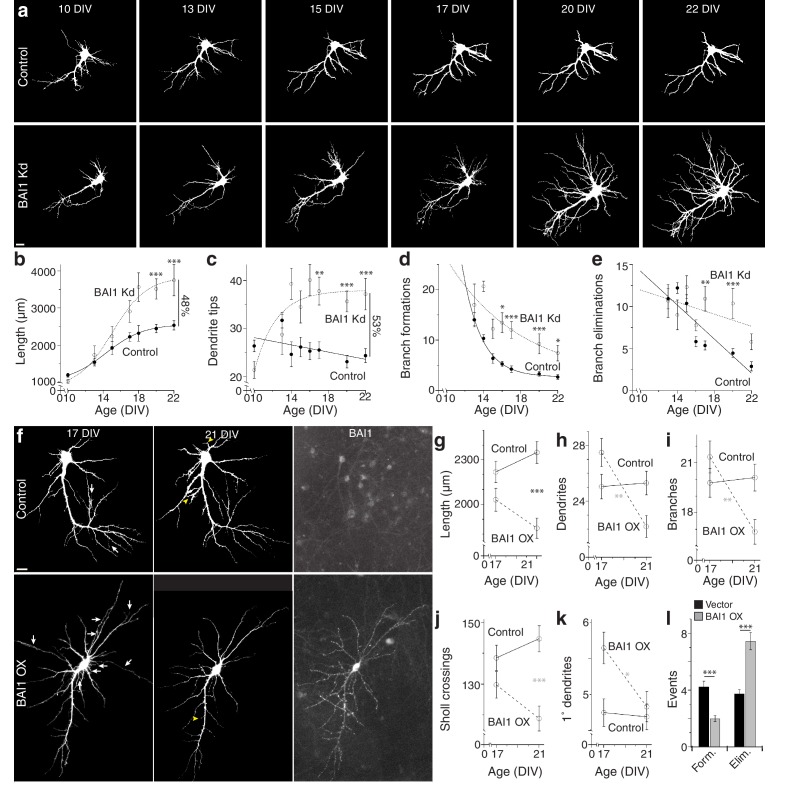
BAI1 exercises its effects on dendritic growth arrest late in development.(a) Representative longitudinal series from neurons transfected on 6 DIV with EGFP (Control) or EGFP and shRNA against Adgrb1 (BAI1 Kd) imaged at the indicated times. Images are masked to remove axons and dendrites from other neurons. Bar is 10 µm. (b) Summary data of total dendrite length. (c) Summary data of total dendrite number. (d) Summary data of branch formations. (e) Summary data of branch eliminations. Total number of neurons represented in panels a–e): 61 for control neurons and 22 for BAI1 Kd neurons (N = 5). Data are represented as mean ± s.e.m. with mathematical fits. (f) Representative longitudinal images of neurons expressing EGFP alone (Control) or with overexpression of Adgrb1 (BAI1 OX). Neurons were fixed on 21 DIV and immunostained for BAI1. White arrows in the 17 DIV panels indicate dendrites eliminated by 21 DIV, while yellow arrowheads in 21 DIV panels indicate dendrites formed since 17 DIV. Images are masked to remove axons and dendrites from other neurons. Bar is 10 µm. (g) Summary data for dendrite length. (h) Summary data for dendrite number. (i) Summary data for branch number. (j) Summary data for integrated Sholl crossings. (k) Summary data for primary dendrites. (l) Summary data for dendrite dynamics. Total number of neurons represented in panels (f–l): 105 neurons (N = 3). Symbols positioned between points indicate differences between populations at the different time points. Data are represented as mean ± s.e.m. (***p<0.0001, **p<0.01, *p<0.05) Detailed statistics are found in Figure 2—source data 1.10.7554/eLife.47566.016Figure 2—source data 1.Statistical summary for Figure 2: ANOVA and key Tukey post-hoc tests and N and n values for Figure 2c–e,g–l.10.7554/eLife.47566.014Figure 2—source data 2.Individual values for BAI1 Kd and OX time course experiments (Figure 2b–e,g–l).10.7554/eLife.47566.015Figure 2—source data 3.Individual values for arbor growth in fixed time courses and BAI1 subcellular staining levels (Figure 2—figure supplement 1c,h).